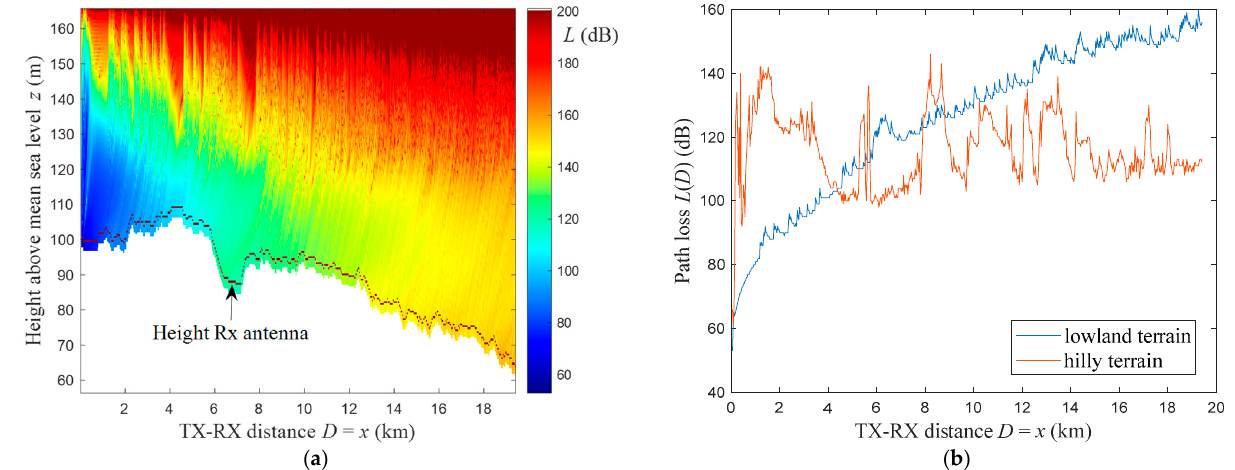
Figure 5. ( a ) Level of receiving antenna height marked above exemplary lowland terrain profile and ( b ) path losses versus terrain profile radius for analyzed receiving antenna height and calcu- lated field distributions from Figure 4.